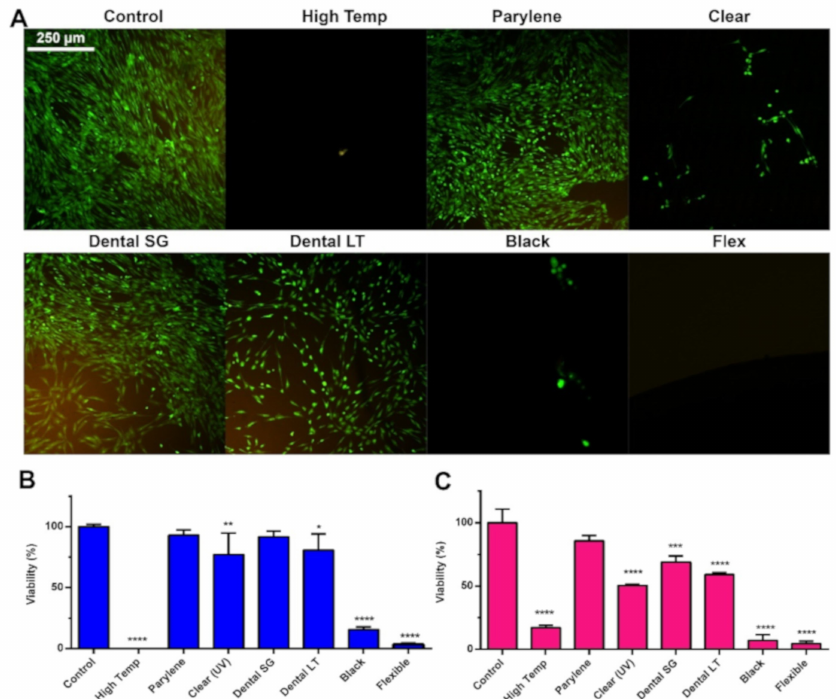
Figure 2. Cytotoxicity testing of resins for additive manufacturing. ( A ) Calcein-AM and PI staining, ( B ) TOX8 viability assay, and ( C ) MTT viability assay of MSCs after 4 days of cultivation with direct contact with the di ff erent resins. Data are given as mean ± SD (n = 4). * p < 0.05; ** p < 0.01; *** p < 0.001; **** p <